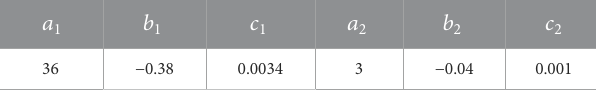
TABLE 3 Calculation coef fi cients of carbon emission.